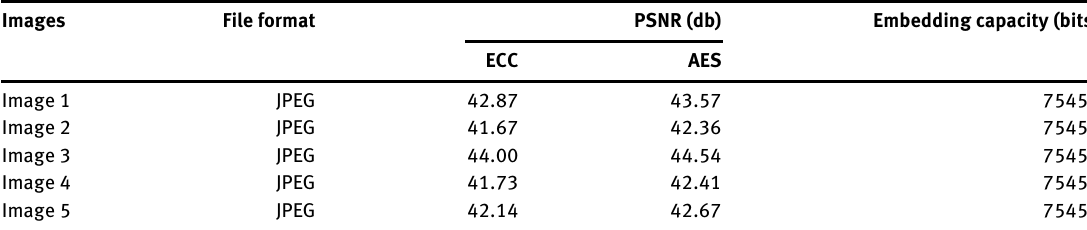
Table 8: Performance of the Proposed Approach Using PSNR Value and Embedding Capacity (bits). Images